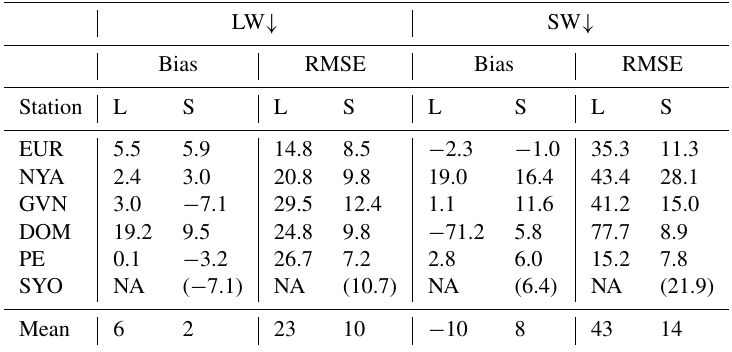
Table 5. Statistical comparison of CloudSat- and CALIPSO-retrieved surface radiative fluxes in terms of bias and RMSE against ground- based AWS observations, between limited-distance sampling <10km from the POI (L) and the smart sampling approach (S). The SYO statistics were not considered in the mean value for the smart sampling approach, since no satellite overpasses were found in the limited- distance